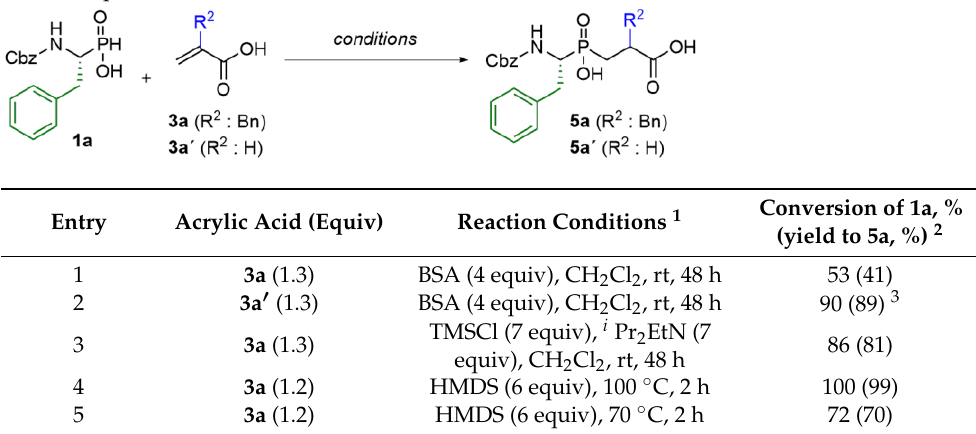
Table 1. Optimization of reaction conditions.